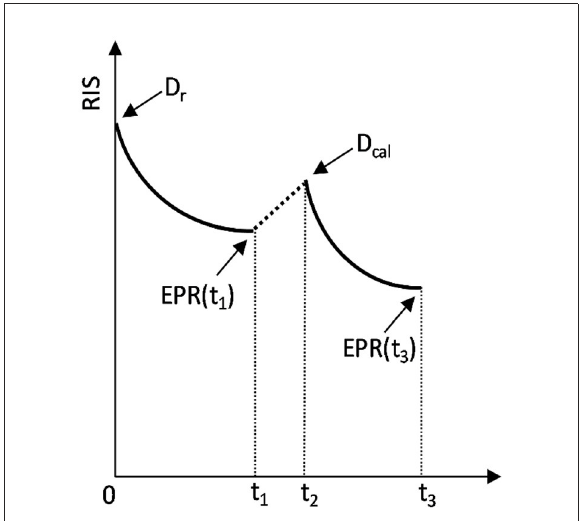
FIGURE1 Schematic representation of the added dose method. The sample was irradiated at t = 0 with the unknown dose D r , measured at t = t 1 , re-irradiated at t 2 with the added calibration dose D cal and measured again at t = t 3 . The arrows marked as EPR ( t 1 ) and EPR ( t 3 ) indicate the two moments of EPR measurements: at t 1 and t 3 , which yield two measured RISes: RIS ( D r ) and RIS ( D r + D cal ),